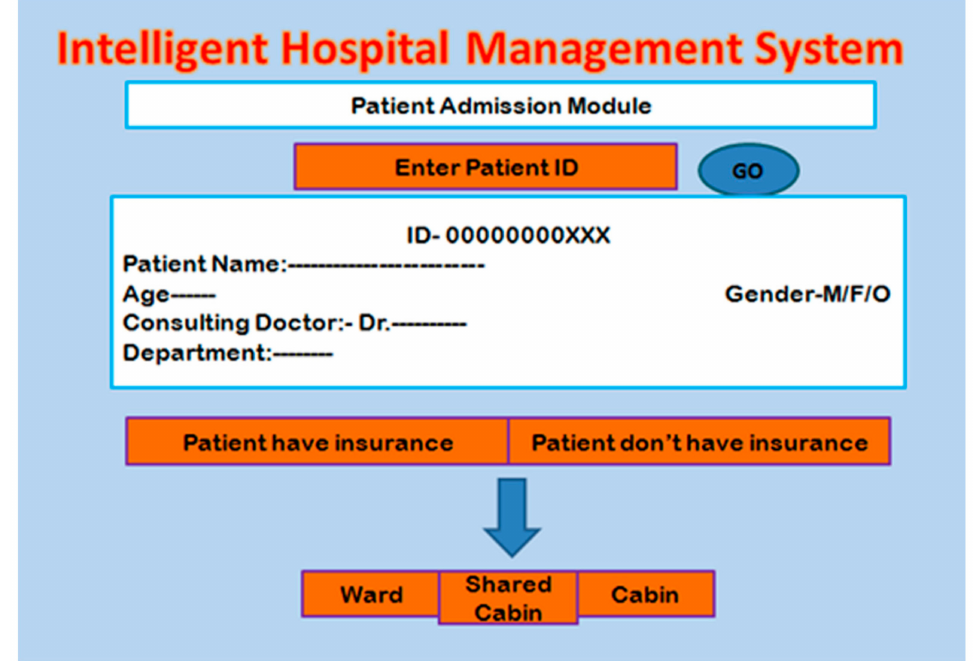
Figure 6. Patient admission